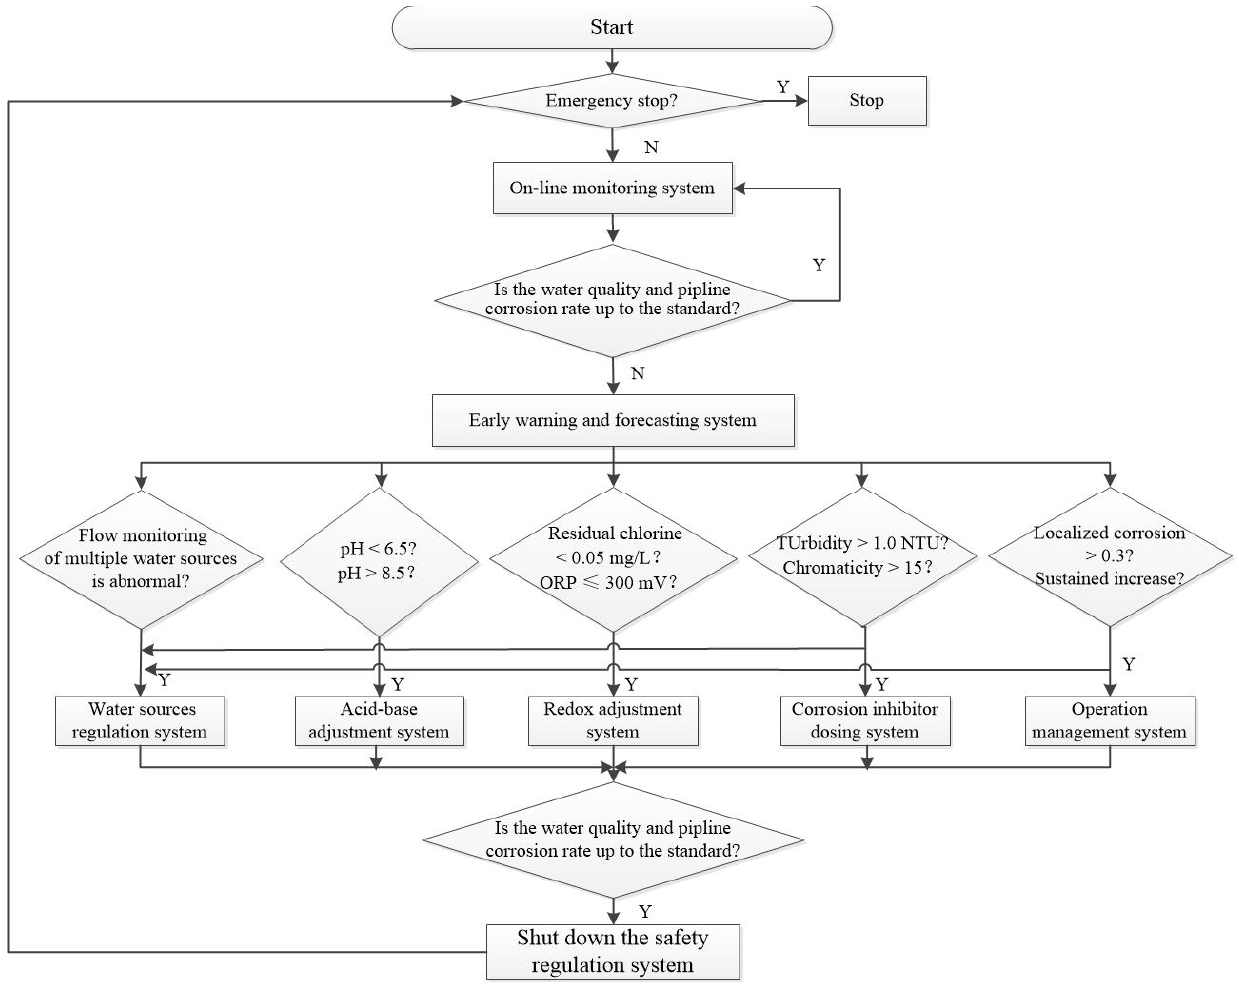
Figure 3. Operation process of the supervision system.